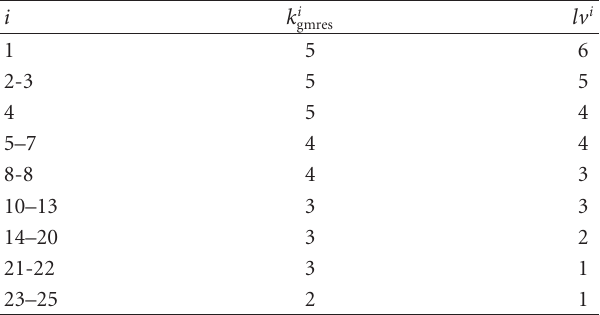
Figure 4: Algorithm SI. Behavior of the relative residual (cid:12) r i (cid:12) 2 / (cid:12) r 0 (cid:12) 2 versus 3 scale steps. Δ τ SI = 0 . 16.